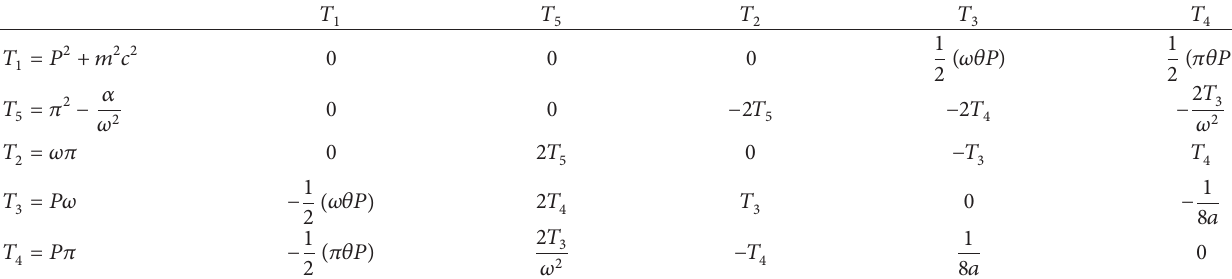
Table 1: Algebra of